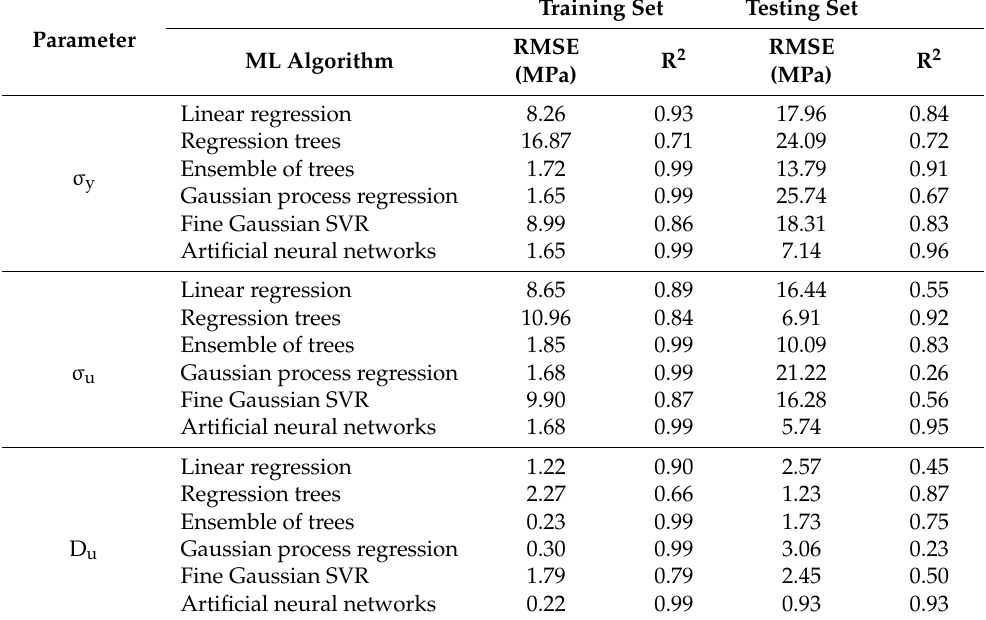
Table 4. Evaluation metrics of σ y machine learning models for both the training and testing